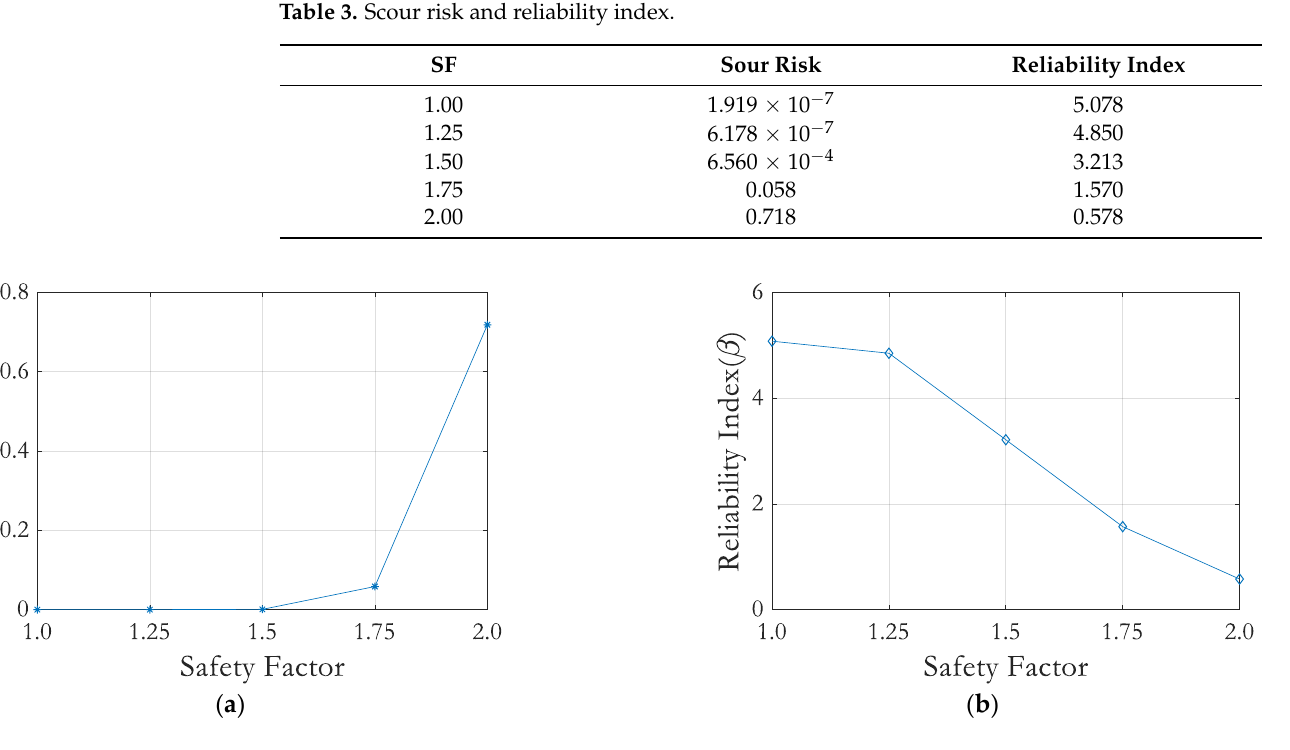
Figure 17. Result of scour risk and reliability index: ( a ) scour risk; ( b ) reliability index. Table 3. Scour risk and reliability index.